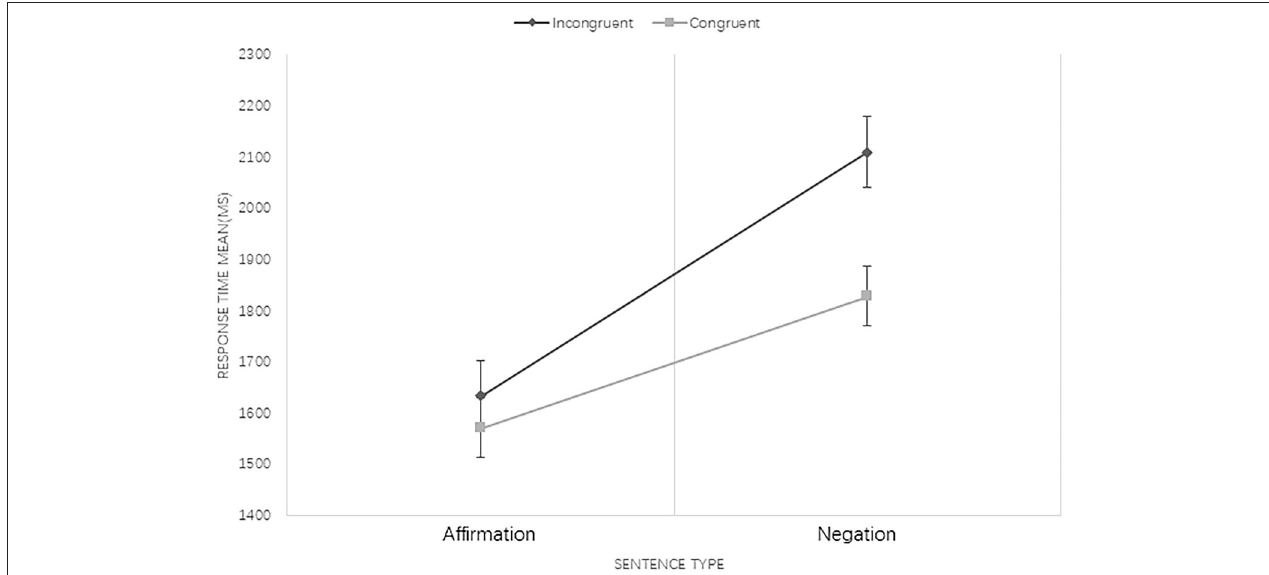
FIGURE 3 | The interaction between congruency condition and sentence type at 750 ISI. Bars represent standard error.